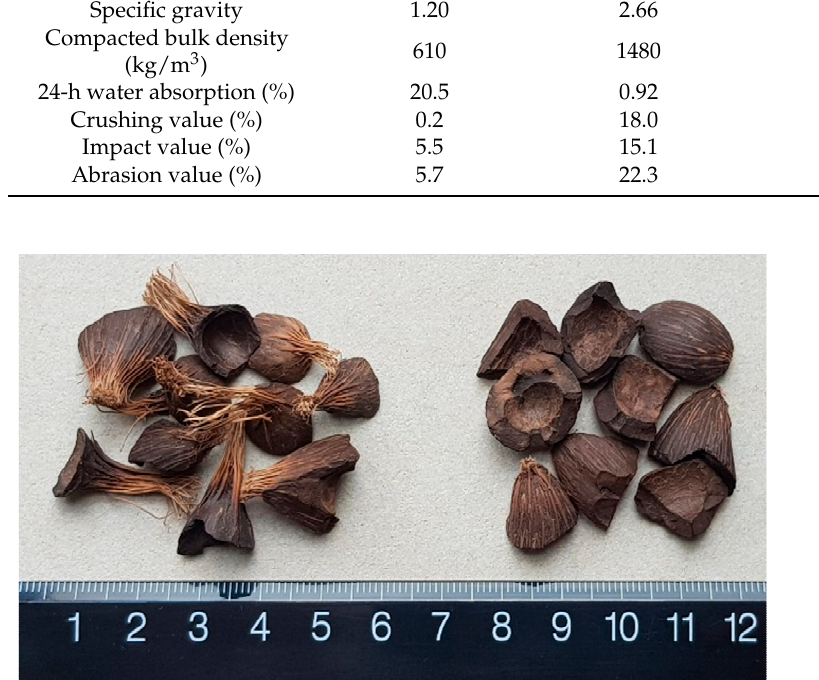
Figure 3. OPS aggregates before and after removing of the surface fibers.